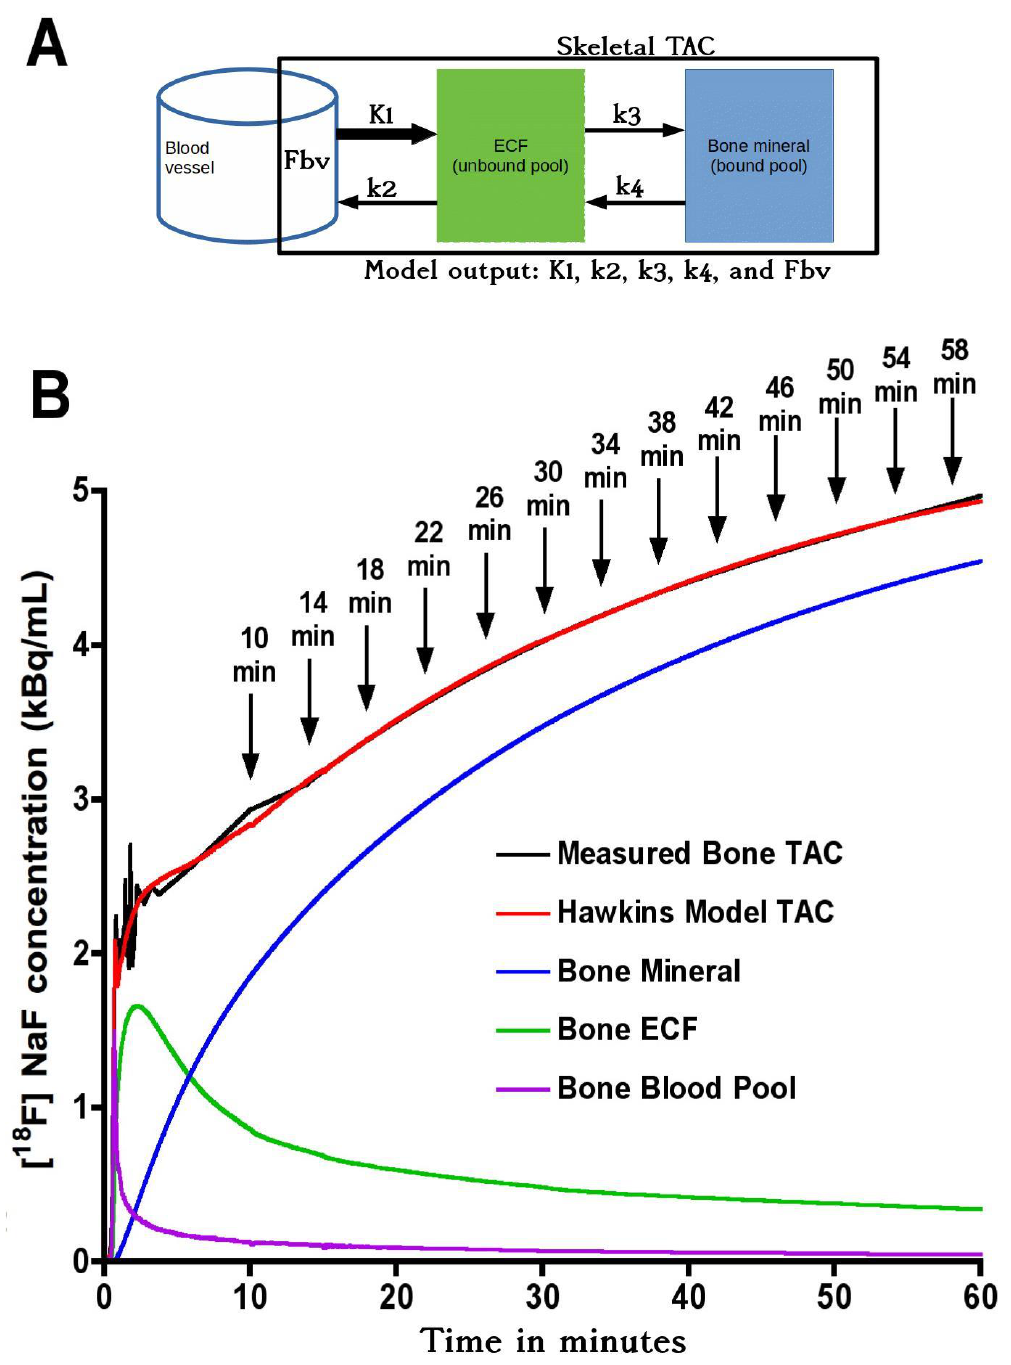
Figure 1. ( A ) Hawkins model with extracellular fluid (ECF) and bone mineral compartments. The black rectangular boundary shows the skeletal volume of interest (VOI) used to obtain the bone time–activity curve (TAC), which includes the fractional blood volume (F bv ). K 1 and k 2 represent the forward and backward tracer exchange rates between blood and ECF, and k 3 and k 4 represent the forward and backward tracer exchange rates between ECF and bone mineral. Values of bone metabolic flux (K i ) were calculated using Equation (1). ( B ) Variation of tracer concentration in different compartments of the Hawkins model between 0 and 60 min. Times marked with arrows show the mid-times of successive 4-min frames. Short-scan values of K i were calculated for each 4-min frame with mid-times between 10 and 58 min (corresponding to full dynamic scan times between 12 and 60 min).